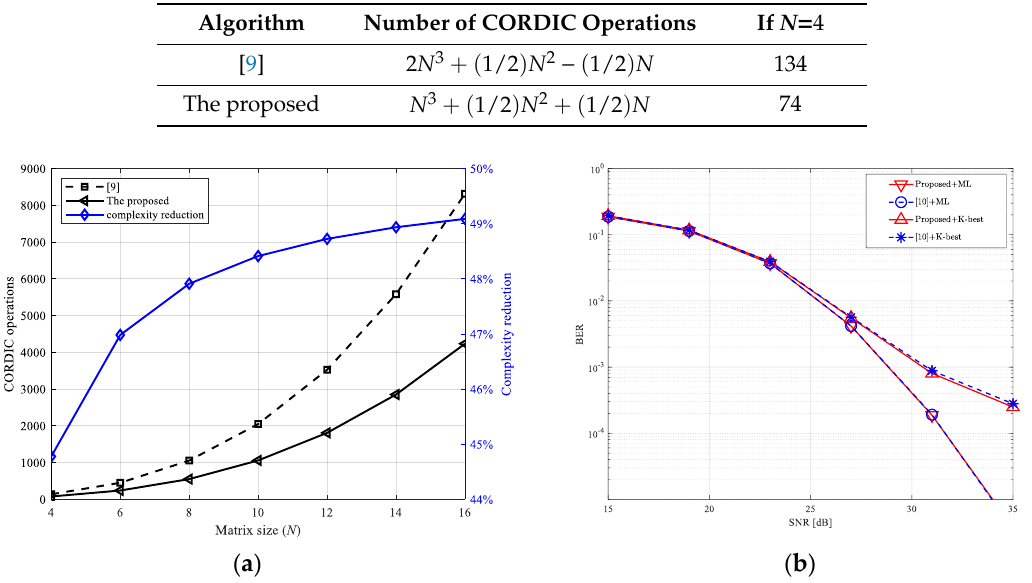
Figure 2. Performance comparisons with the design in reference [9]: ( a ) complexity performance for different matrix sizes; ( b ) uncoded bit error rate (BER) performance in 4 × 4 64-QAM multiple-input multiple-output (MIMO) system.